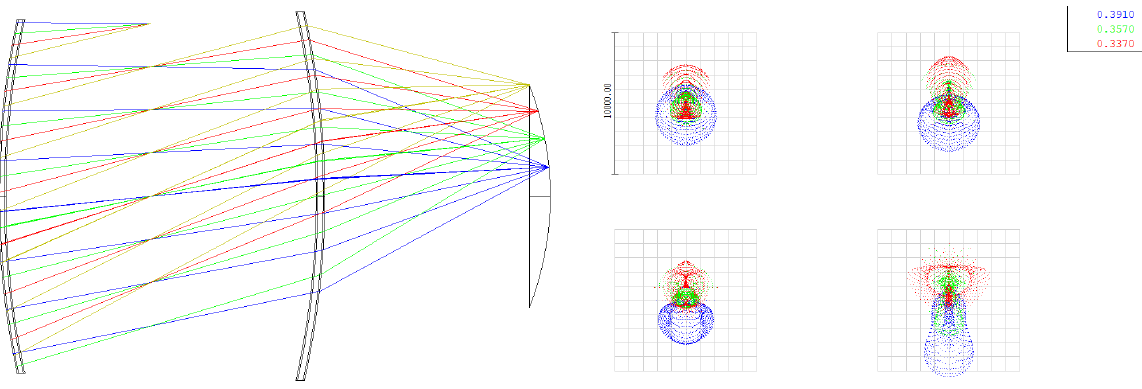
Figure 2. ( Left ): K-EUSO optical scheme as sequential ray tracing (SRT) model in Zemax. ( Right ): spot diagrams for γ = 5 ◦ ,10 ◦ ,15 ◦ ,20 ◦ . The grid cell has a size of 1 mm × 1